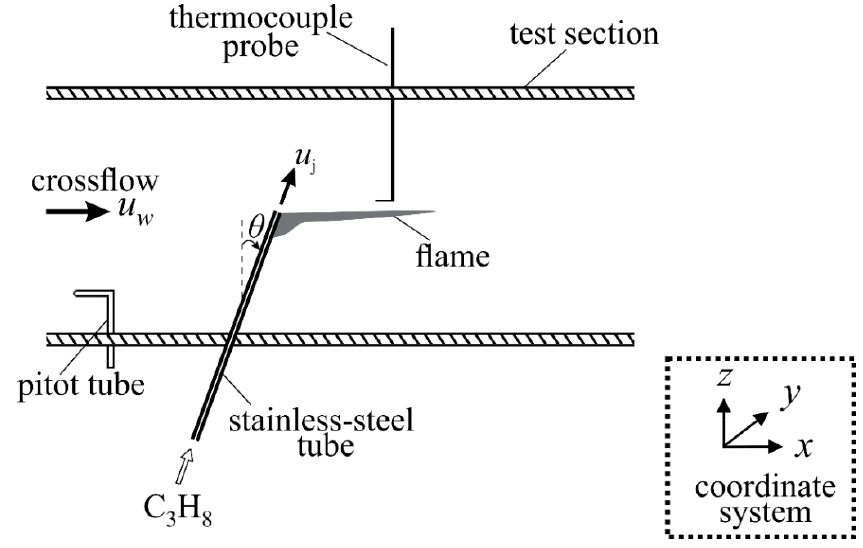
Figure 1. Experimental setup.